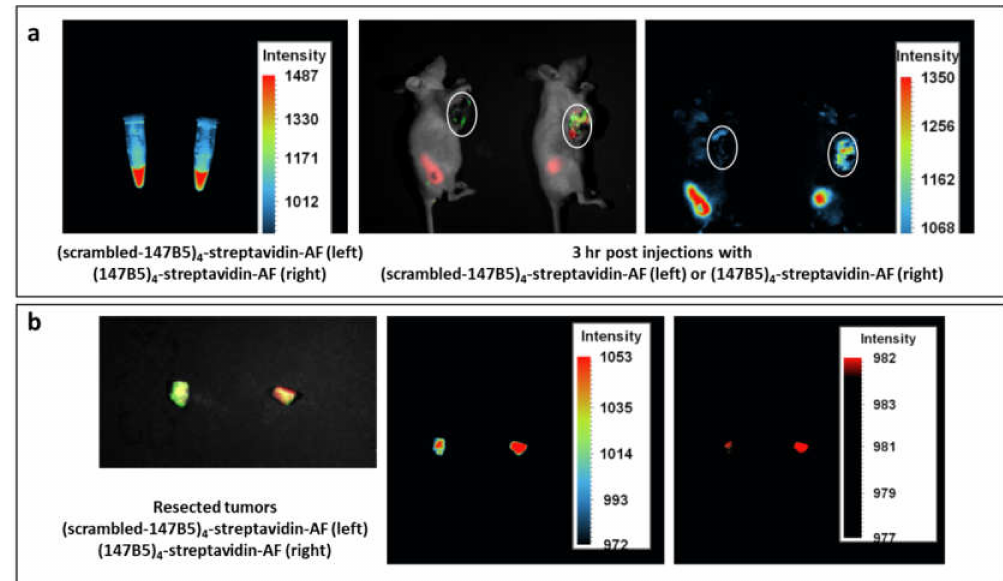
Figure 5. (147B5) 4 -streptavidin-AF accumulates in breast cancer. ( a ) Mice harboring orthotopic human breast cancer MDA-MB-231-GFP (white circles) were treated with either (147B5) 4 -streptavidin-AF or its control (scrambled-147B5) 4 - streptavidin-AF (100 µ L, via tail vein, 10 mg/kg) and images were taken at various time points. ( b ) images for the resected tumors from the experiment in ( a